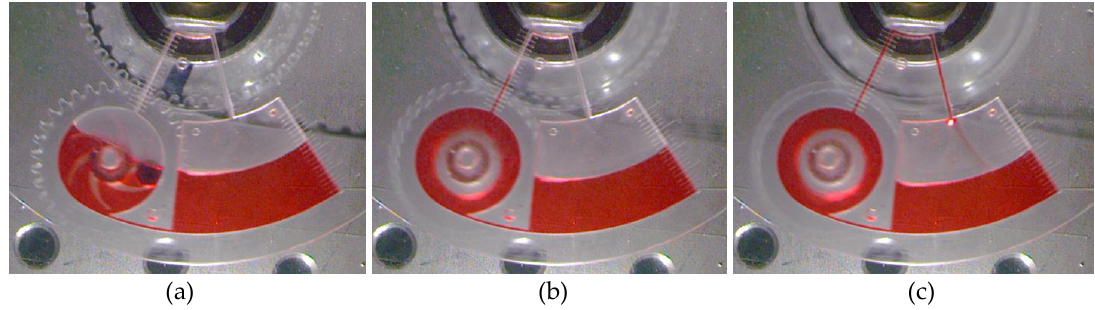
Figure 5. Continous pumping mechanism on a microfluidic CD at 400 spining speed, ( a ) initial state (without pumping), ( b ) during pumping, and ( c ) during fluid’s circulation (Continous pumping).